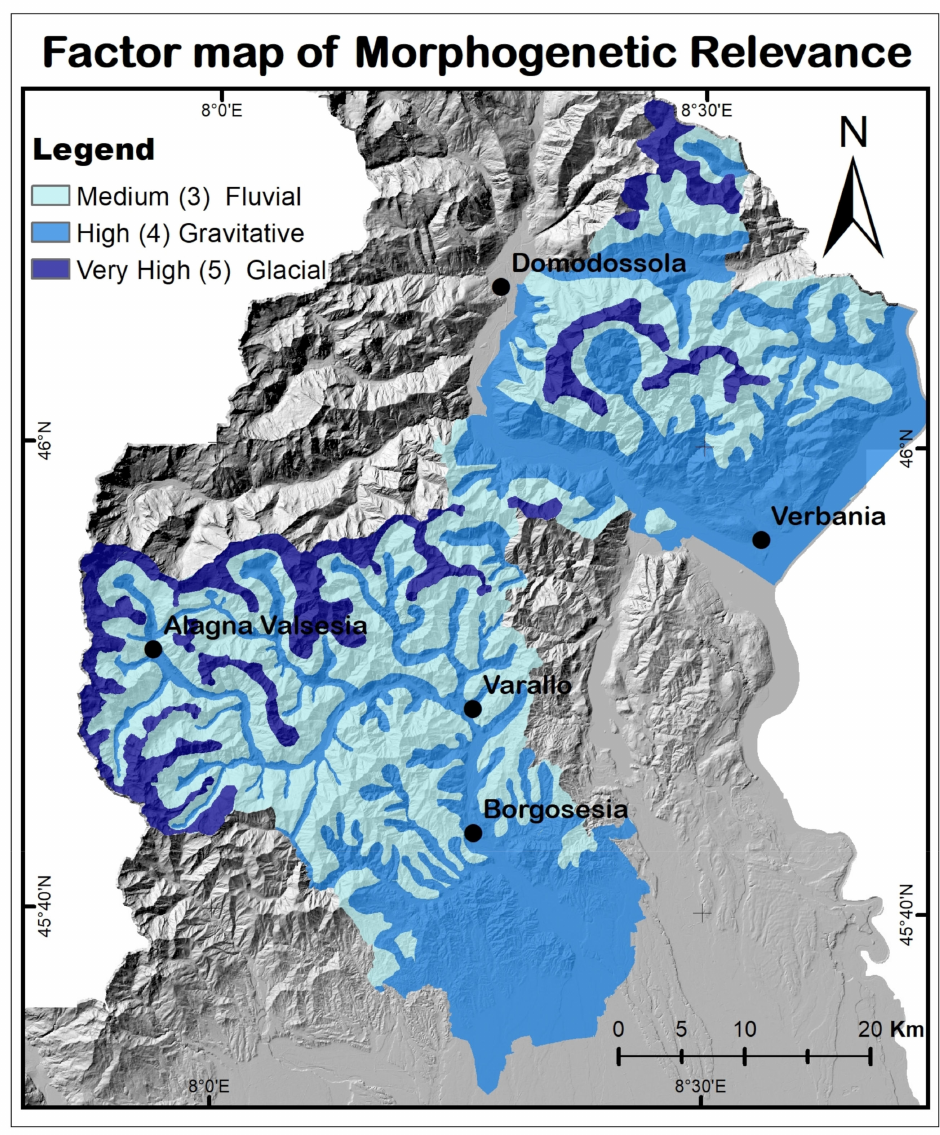
Figure 9. Factor map of morphogenetic relevance